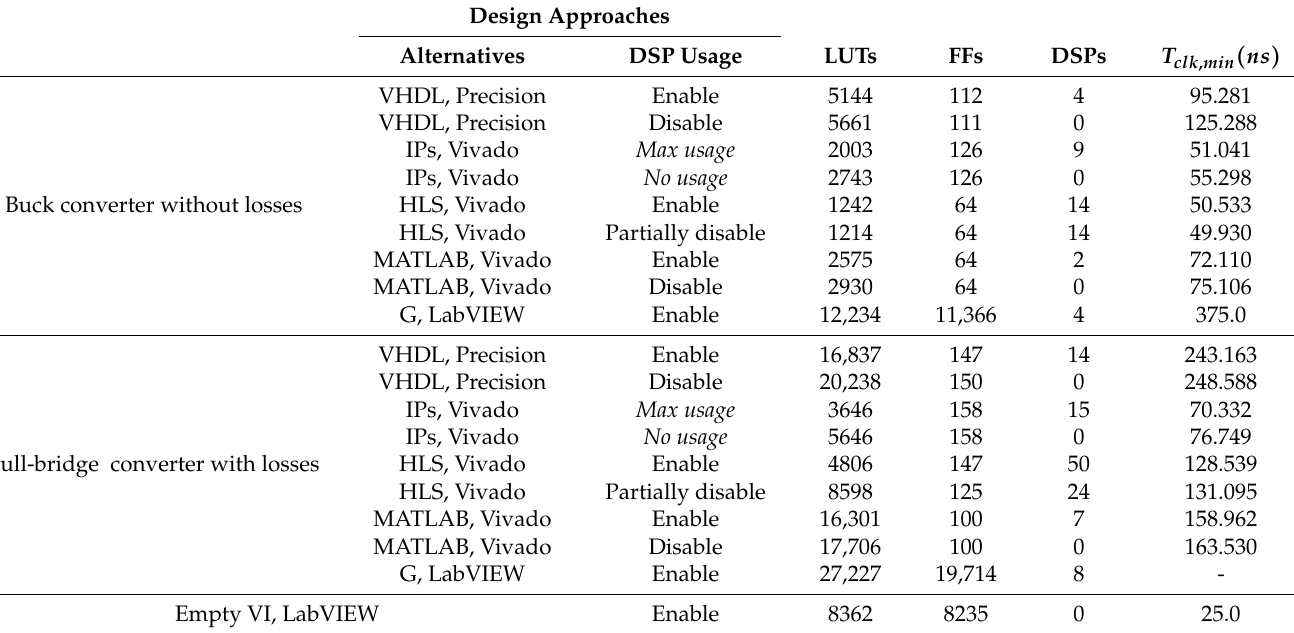
Table 2. FPGA resources use in RT for floating-point design